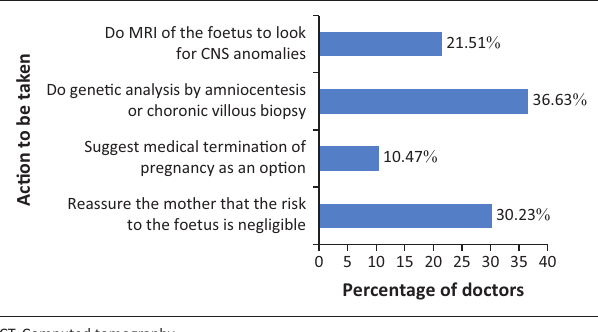
FIGURE 2: Action to be taken according to American College of Radiology guidelines in a case of a pregnant woman that underwent computed tomography abdomen and pelvis with contrast, as her pregnancy status was not enquired into by the computed tomography technologist before performing computed tomography ( n =